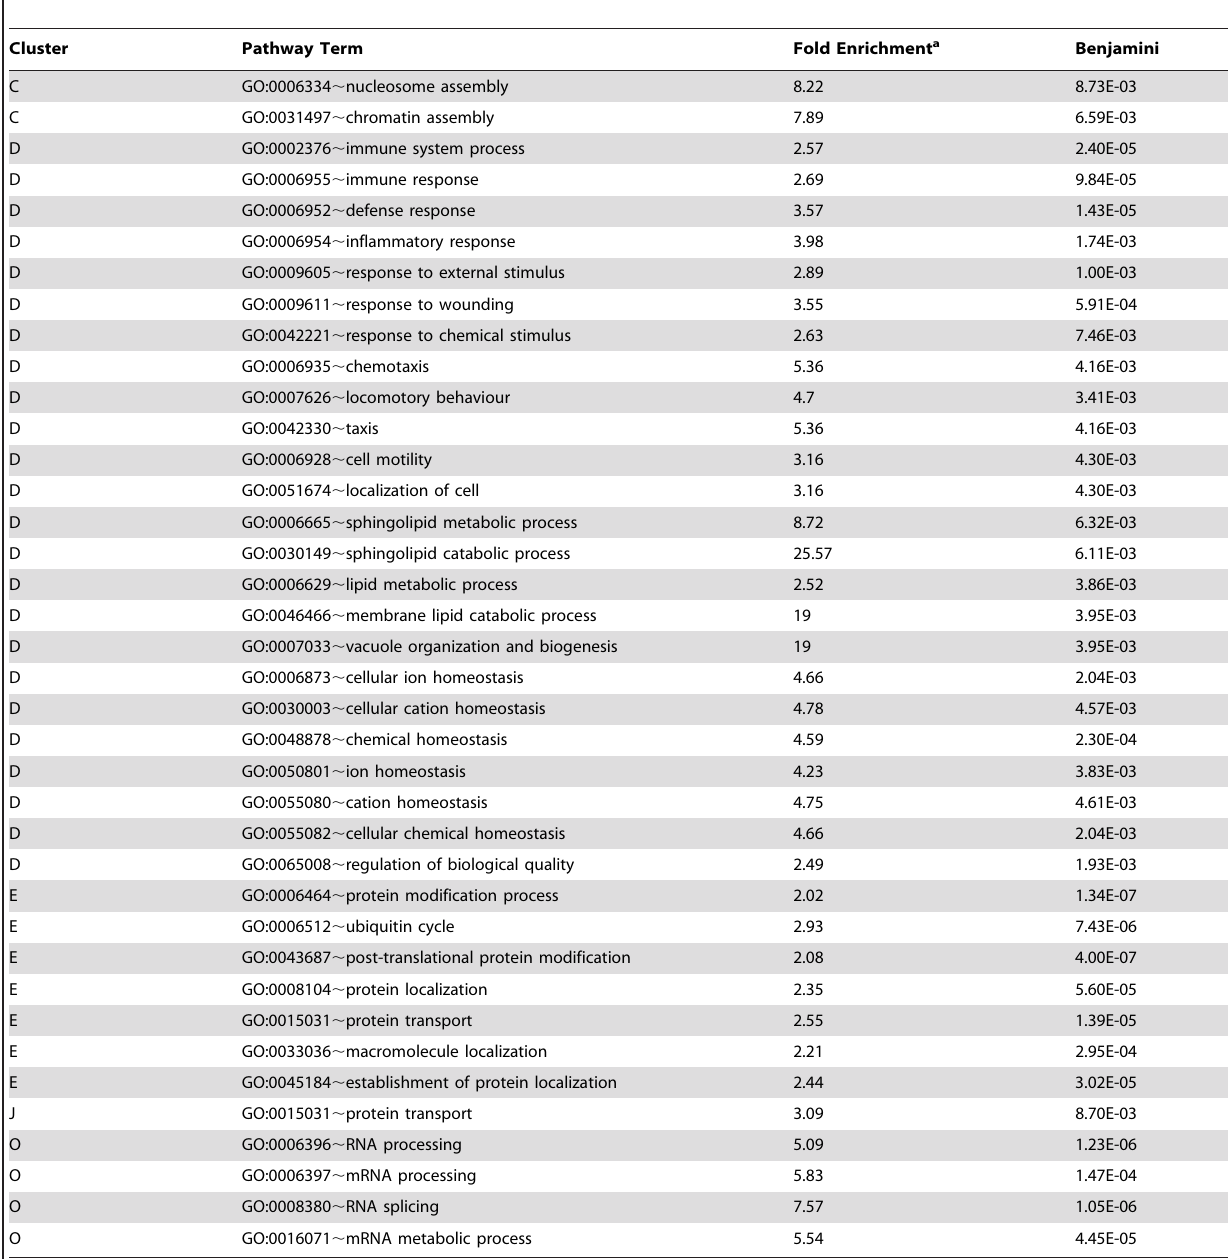
Table 1. Pathways identified by DAVID analysis of the two-way SAM gene list of serum-free versus serum-containing fibrocytes.